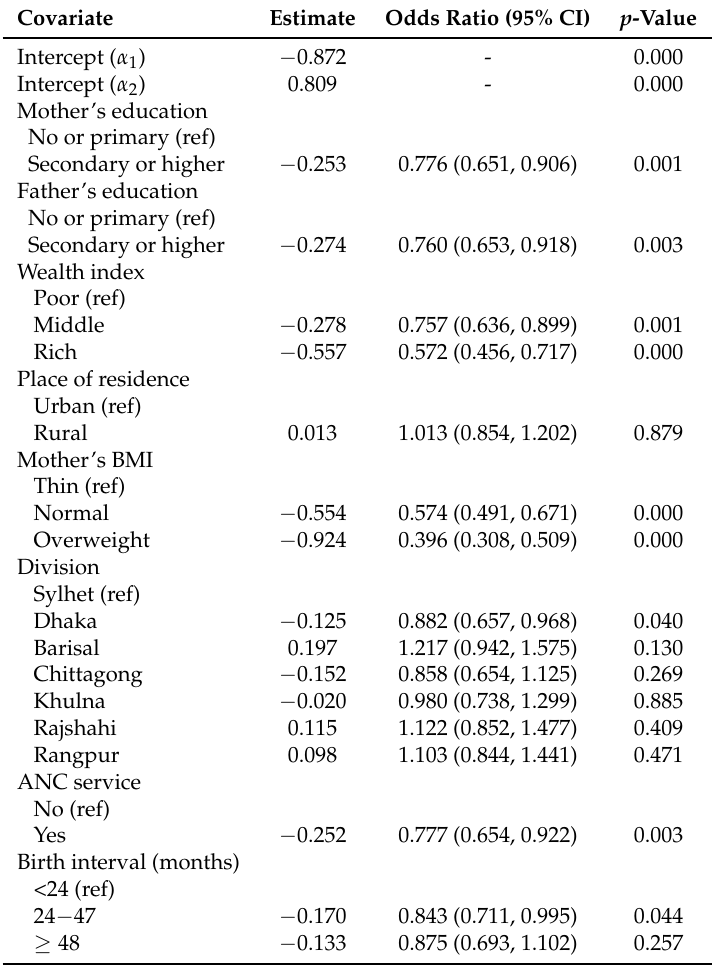
Table 2. Proportional odds model based estimated effects of selected